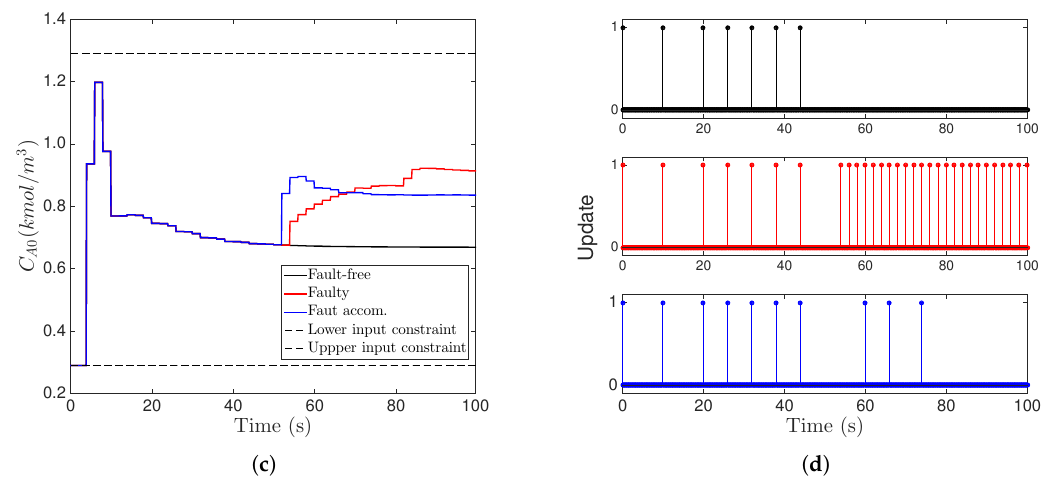
Figure 6. Comparison of the performance of forecast-triggered MPC scheme under fault-free conditions (black), an accommodated fault scenario (blue) and an unaccommodated fault scenario (red): ( a ) closed-loop temperature profiles; ( b ) reactant concentration profiles; ( c ): manipulated input profile; and ( d ): model update